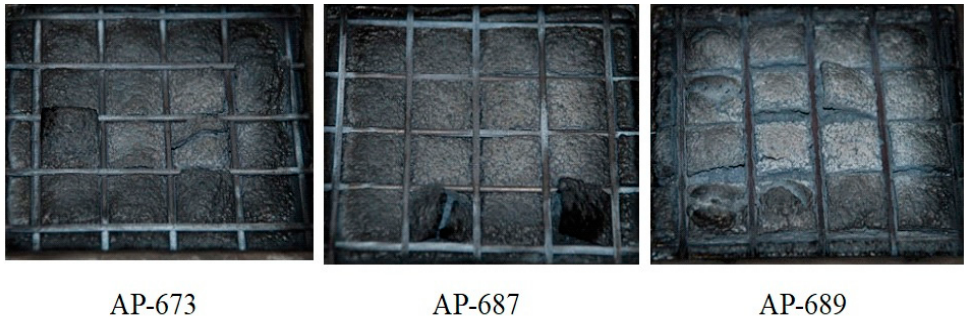
Figure 16. Photographs of the residua after cone calorimeter test of AP ‐ 673, AP ‐ 678 and AP ‐ 689.